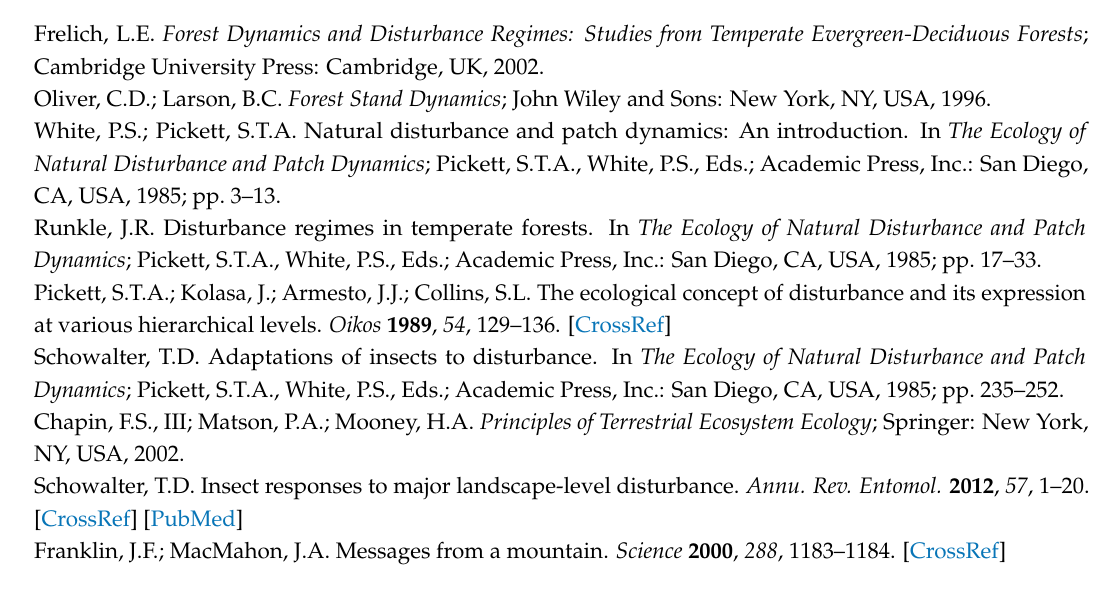
Table S1: Summary of studies investigating the effects of canopy gap formation, coarse woody debris (CWD) accumulation, and salvage harvesting in forest